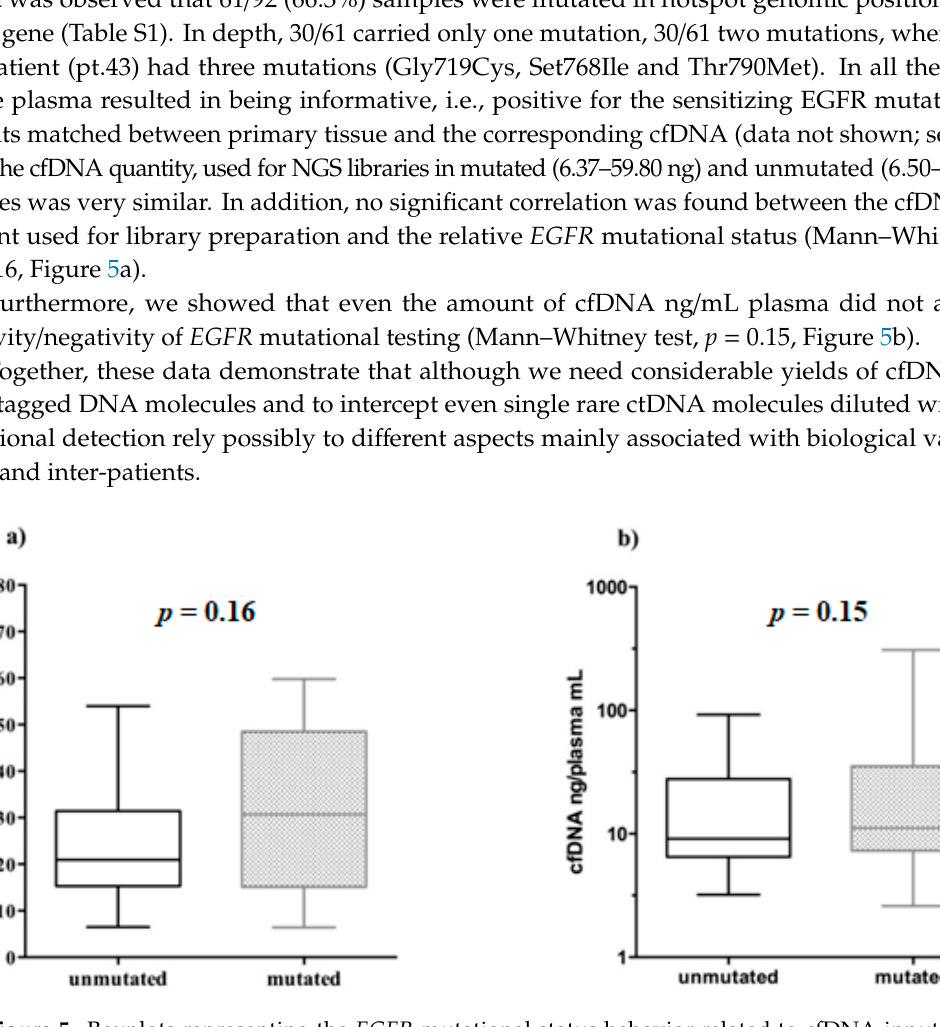
Figure 5. Boxplots representing the EGFR mutational status behavior related to cfDNA input and abundance. Unmutated/mutated plasma samples were correlated with: ( a ) the cfDNA amount used for library preparation; ( b ) cfDNA abundance in plasma (cfDNA ng/plasma mL).